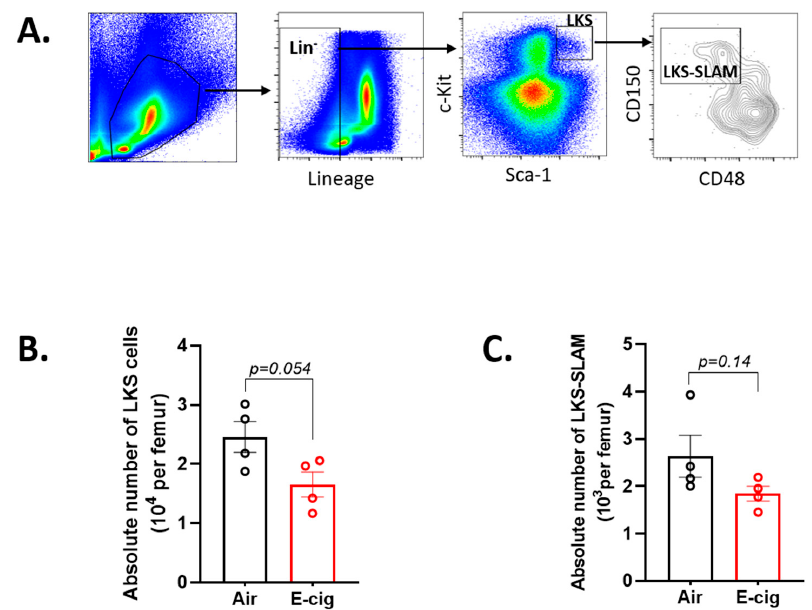
Figure 3. E-cigarette exposure suppresses HSPC numbers in the bone marrow. ( A ) Gating scheme for the characterization of HSPC sub-types. Absolute numbers of ( B ) LKS and ( C ) LKS-SLAM populations per femur. Data are shown as mean ± SEM, n = 4 mice / group. p -value determined by unpaired student’s t -test .